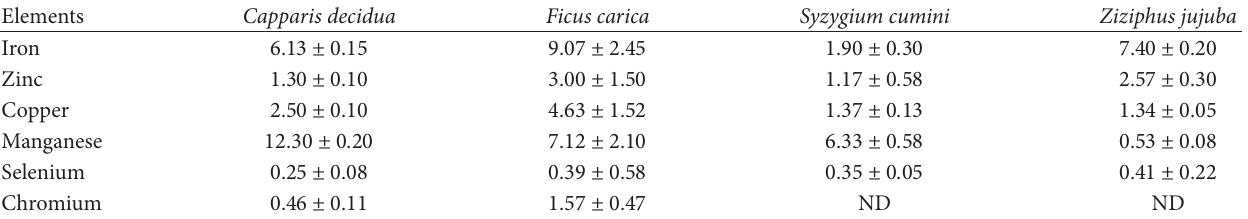
Values are for triplicate determination (mean ±